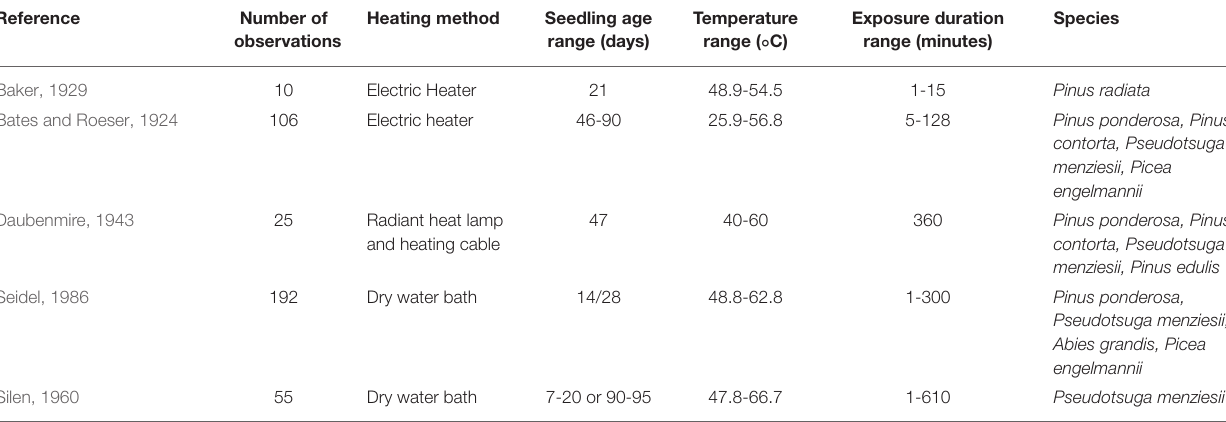
TABLE 1 | Summary of information from the five studies used in this analysis.